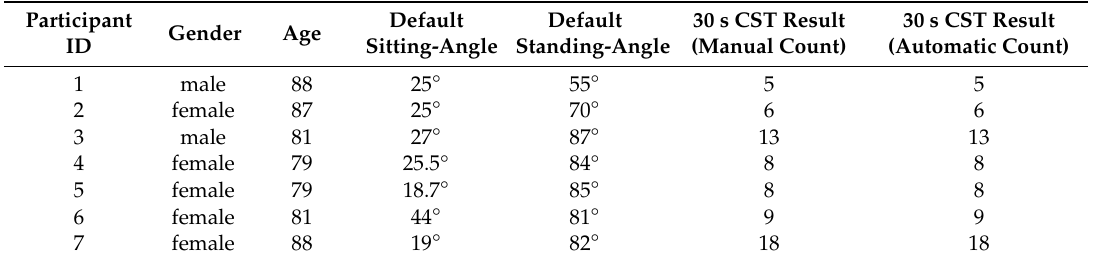
Table 3. Data collected during the experimental procedure. Each row in the table holds the data for one of the seven older adults in the experiment (age: m = 83.29 years old, sd = 4.19; gender: 5 female and 2 male). Each participant took a single 30-s CST. The outcomes from the sensor automatic count match the outcomes from the trained professional’s manual count for all the seven participants. All the 67 SiSt transitions that took place were correctly identified, and the mean absolute error was equal to zero.